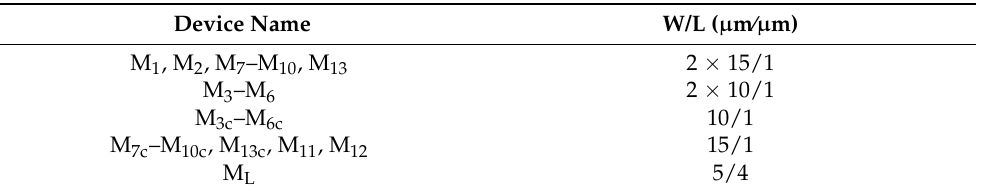
Table 2. Transistor Aspect Ratio of the G m .